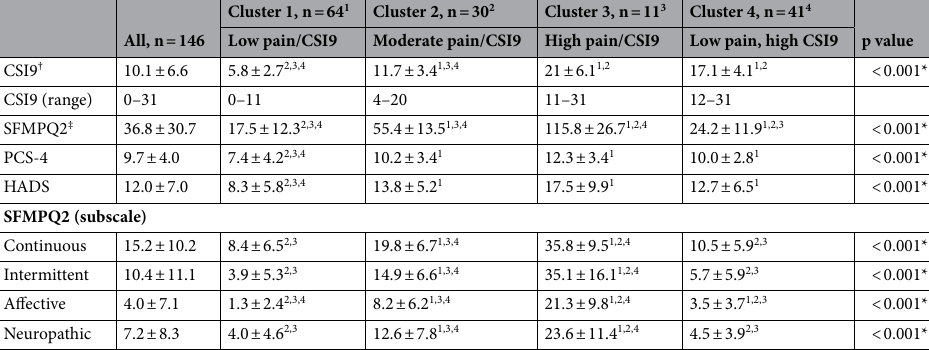
Table 1. Means, standard deviations, Kruskal–Wallis test p-values, and in between group comparisons for the 4 subgroups/clusters based on CSI9 and SFMPQ2. Mean ± SD. CSI9 central sensitization inventory-9 (CSI short form), SFMPQ2 short form McGill pain questionnaire-2, PCS-4 pain catastrophizing scale-4, HADS hospital anxiety and depression scale. † Cluster1 < 2 < 3 = 4. ‡ Cluster1 < 4 < 2 < 3. *Assessed by Kruskal–Wallis test. Superscript numbers indicate which groups were significantly different in the post hoc comparisons, with a significance level of p < 0.008 (Bonferroni correction).